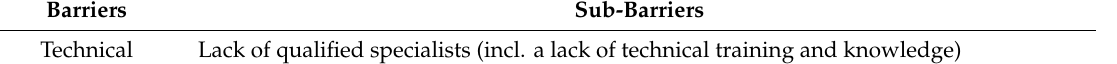
Table 3. Critical barriers to the wider implementation of biogas technologies in Russia. Barriers